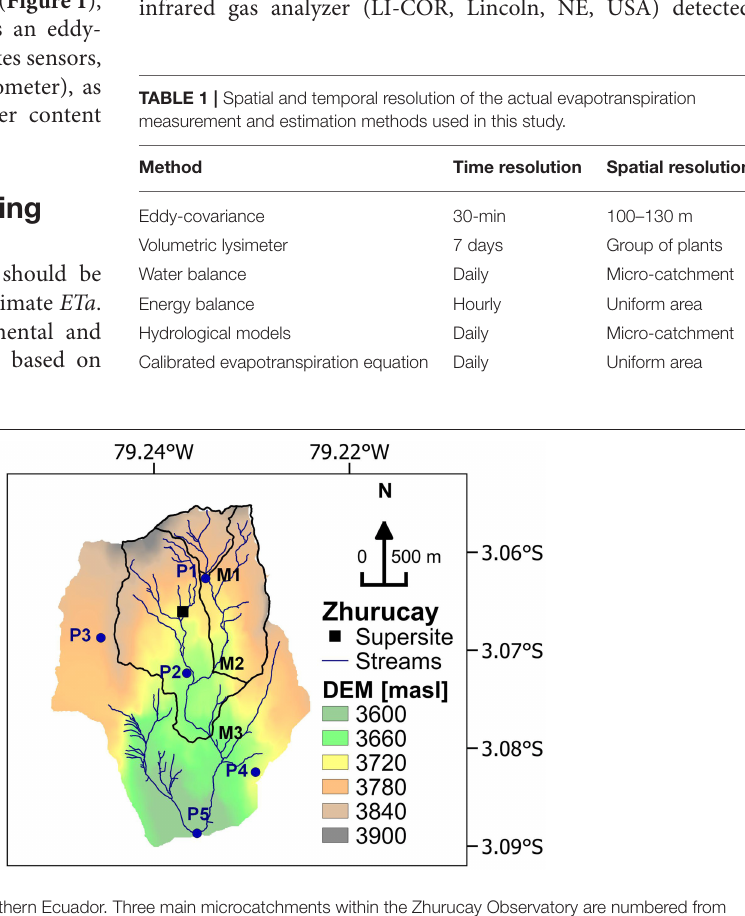
FIGURE 1 | Zhurucay Ecohydrological Observatory located in Southern Ecuador. Three main microcatchments within the Zhurucay Observatory are numbered from M1 to M3 and five rain gauges are numbered from P1 to P5.